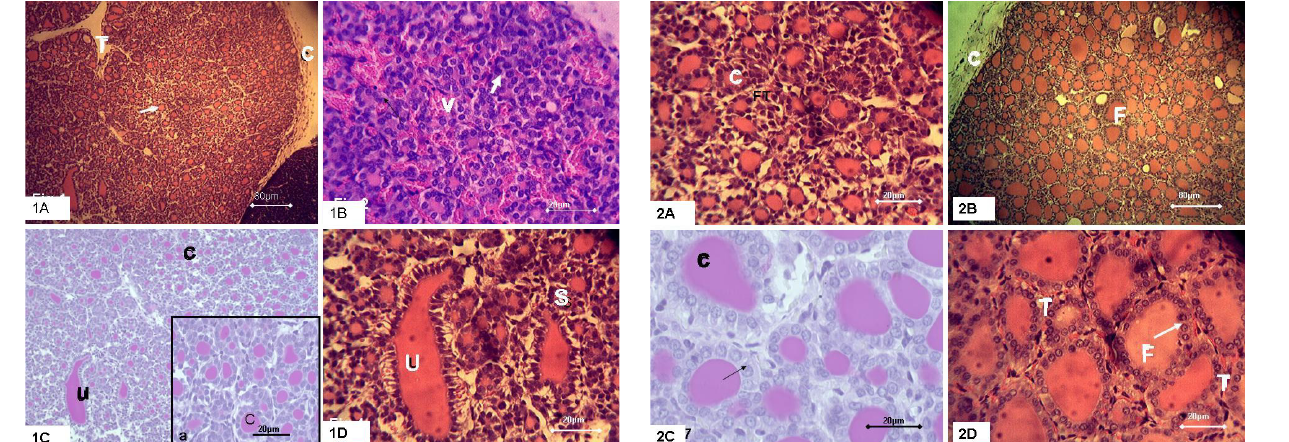
Fig. 1A. Photomicrograph of section of foetal thyroid (50-70 days), showing developing capsule (C), parathyroid (P), trabeculae (T) and parenchyma with numerous small sized follicles (arrows), some cells were in cords without definite organization. H – E (bar scale: 80 μm); Fig. 1B. Thyroid sections showing highly vascular parenchyma (V) and mitotic cells and cell cords without lumen (arrow heads). H – E (bar scale: 20 μm); Fig. 1C. Photomicrograph of foetal thyroid of WADG (50-70 days): showing PAS positive colloid with some unusual irregular follicle (arrow) present. Small follicles were predominant. Some do not contain colloid. PAS (scale bar 80 μm); Fig 1D. Photomicrographs of sections of thyroid (50-70 days) showing unusual elongated follicles presumed to be ultimobranchial follicles (U) surrounded by small-sized follicles (S). H – E (bar scale 20 μm).